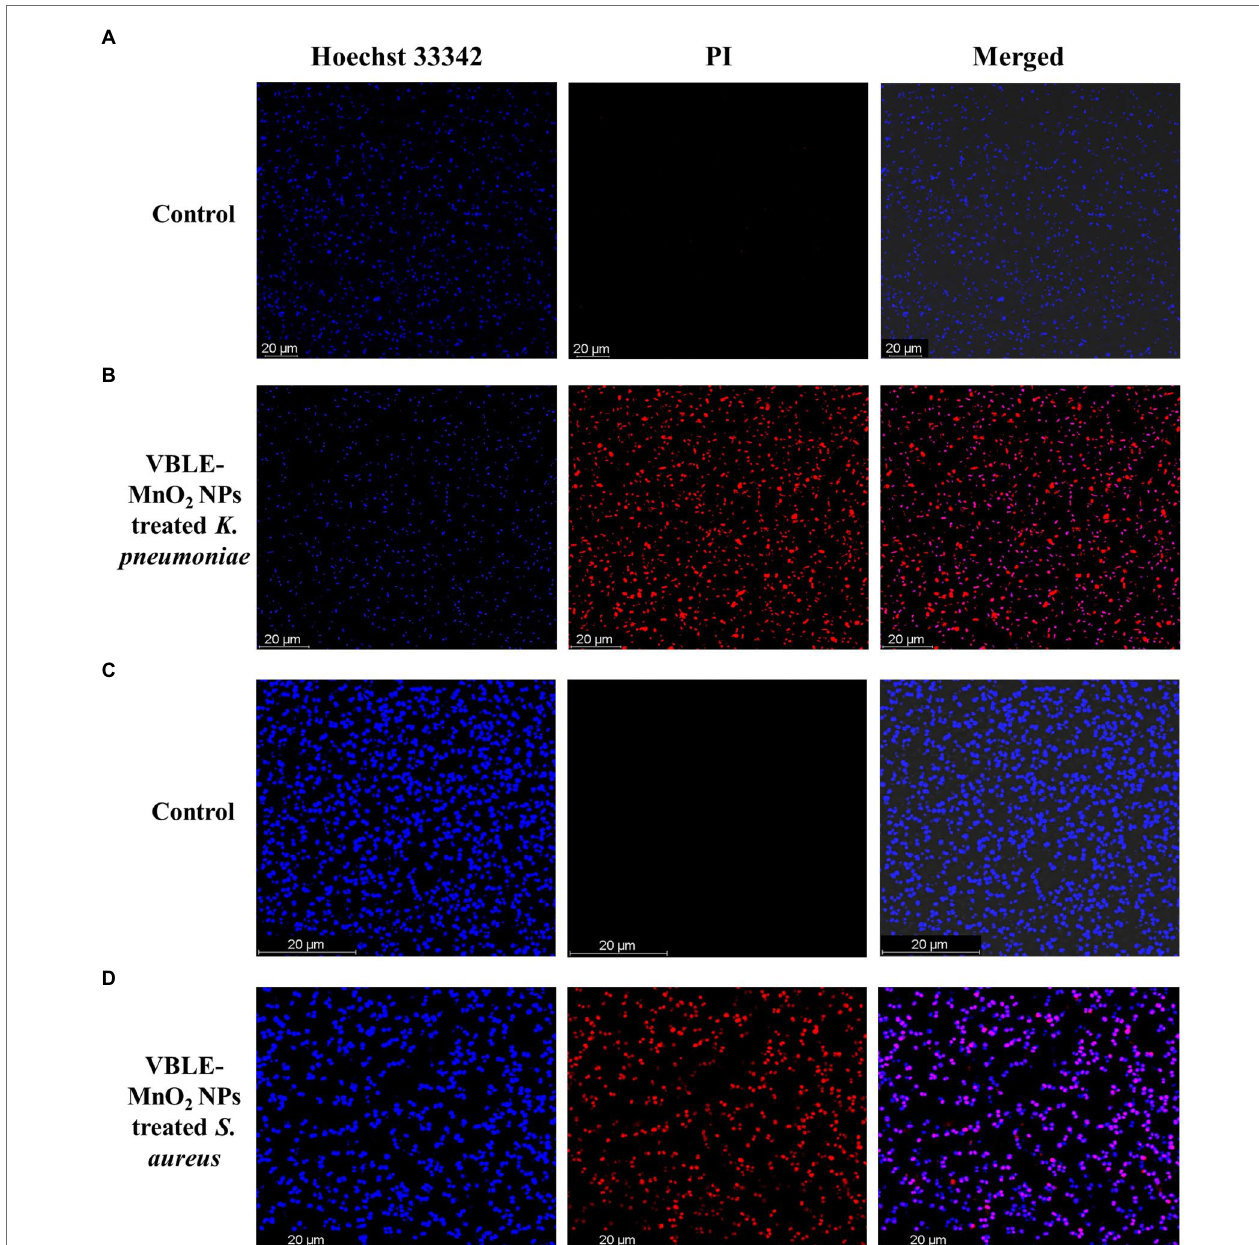
FIGURE 4 | CLSM images of untreated [control (A,C) ] and treated (B,D) bacteria with synthesized VBLE-MnO 2 NPs. Red represents dead bacterial